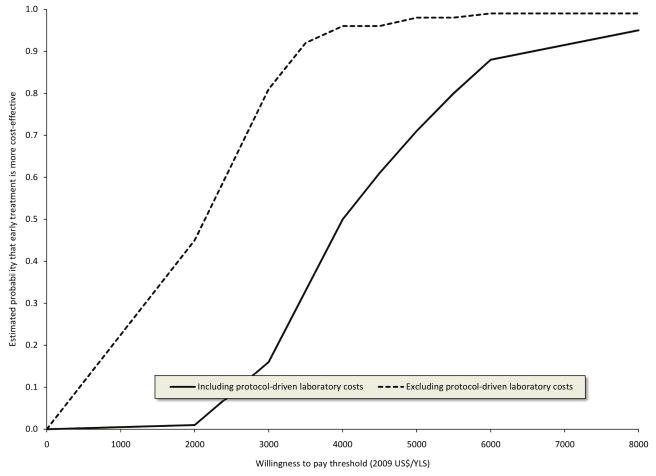
Cost-effectiveness acceptability curves for earlier initiation of ART after a maximum of 3 y including and excluding protocol-driven costs.Curves were constructed from 100 bootstrap simulations including protocol-driven costs and 100 bootstrap simulations excluding protocol-driven costs.